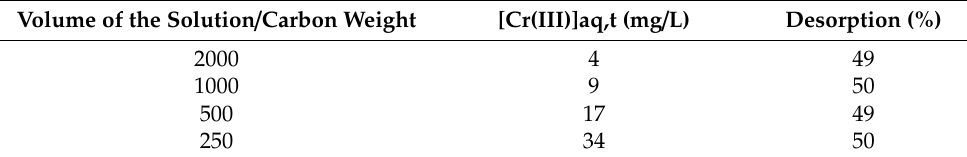
Table 1. Desorption